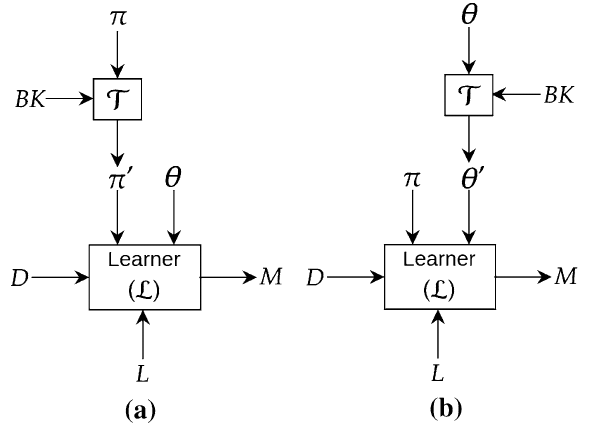
Figure 8. Introducing background knowledge into deep network by transforming the model (structure and parameter). In ( a ), the transformation block T takes a input structure of a model π and outputs a transformed ′ structure π based on background knowledge ( BK ). In ( b ), the transformation block T takes a set of parameters θ of a model and outputs a transformed set of parameters π ′ based on background knowledge ( BK